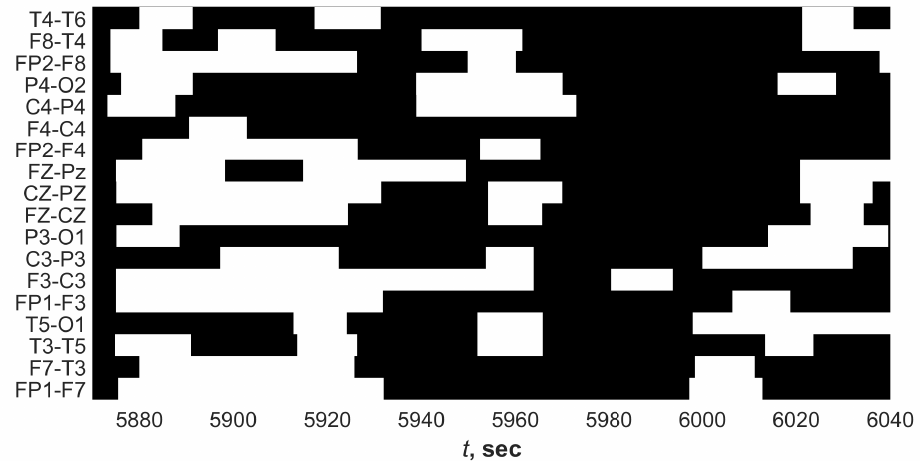
Figure 3. Fragment of daily EEG signal with ES illustrating the frequency of the wavelet spectrogram ridge synchronization in different pairs of EEG channels. Black shows the presence of synchronization. The ordinate shows the labels of channel